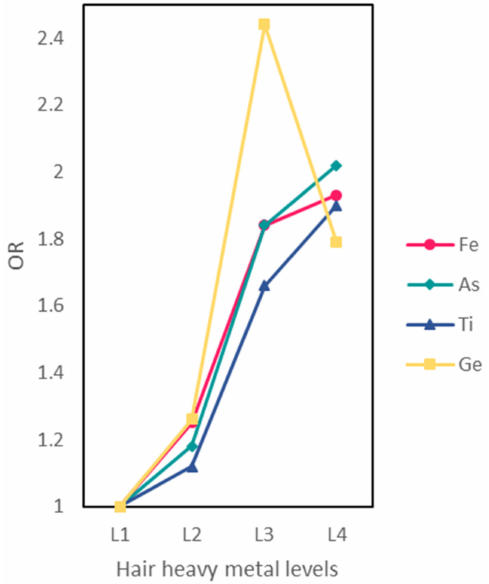
Figure 2. The odds ratio (OR) of heavy metal concentrations and passive smoking. Metal concen- trations were classified into four levels by quartiles of all subjects, i.e., <1st quartile (L1), 1st–2nd quartile (L2), 2nd–3rd quartile (L3), >3rd quartile